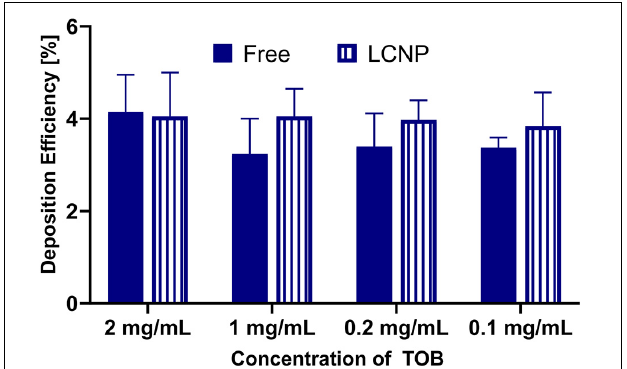
FIGURE 5 | Comparison of deposition efficiency of free and LCNP encapsulated tobramycin (TOB), either as a free solution or in LCNPs after nebulizing 200 µ l with Aerogen R (cid:13) Pro nebulizer and nebulization chamber into 24-well plates. Data represented as mean ± standard deviation, N = 9 (of three experiments). Two-way ANOVA, Sidak’s multiple comparisons test. No significant difference ( p > 0.05) was found between the